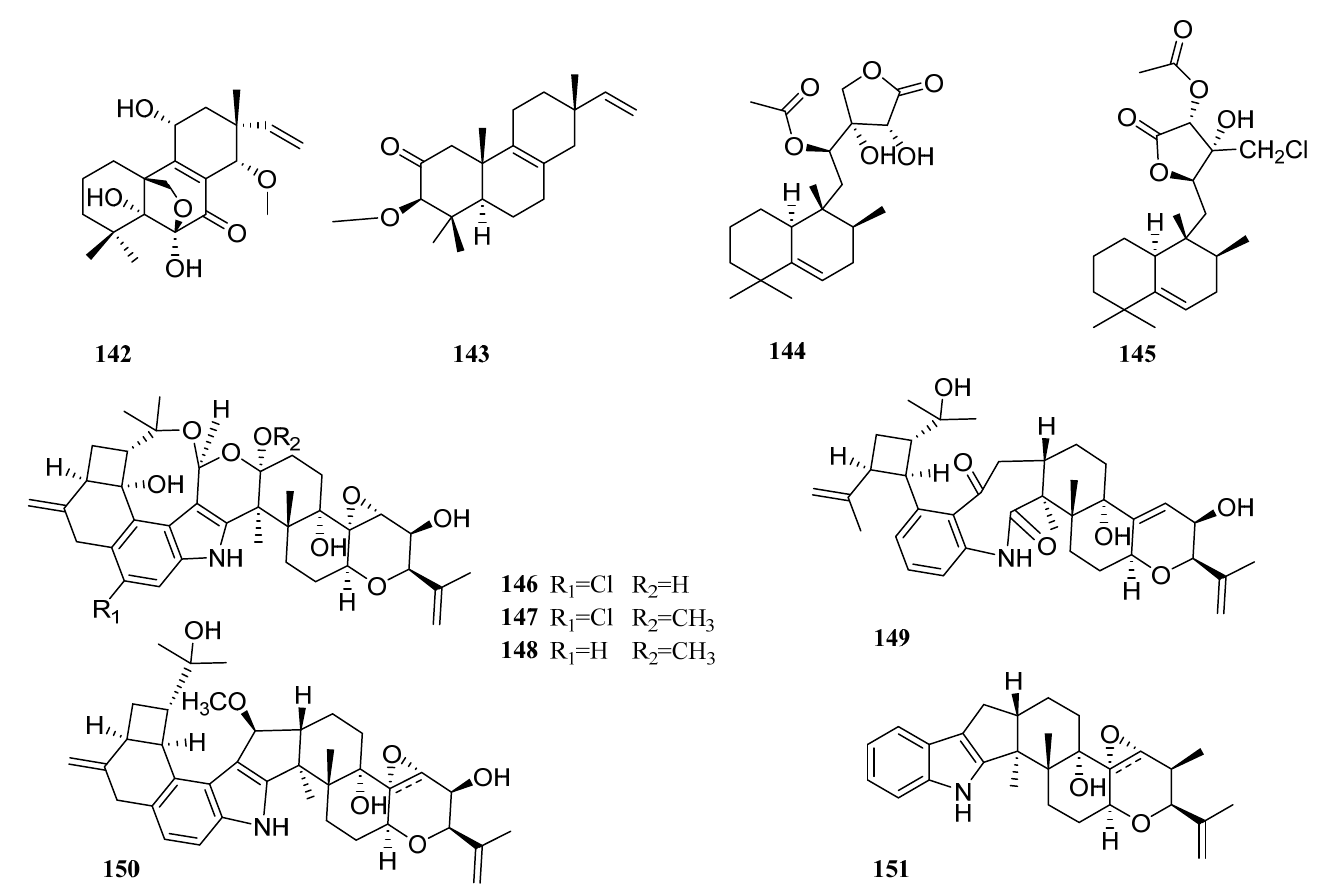
Figure 7. Chemical structures of diterpenes ( 128 from Curvularia sp., 129 – 131 from Eupenicillium sp., 132 – 138 from Eutypella sp., 139 – 142 from Epicoccum sp., 143 – 145 from Micromonospora sp., and 146 – 151 from Mucor sp.).